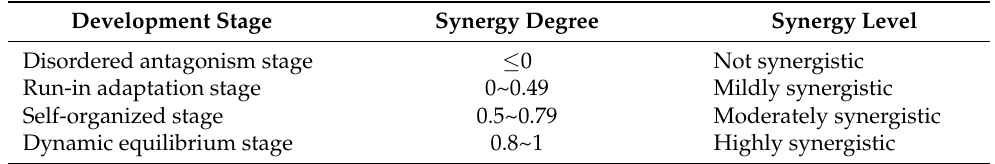
Table 2. Division of system synergistic development stage. Development Stage Synergy Degree Synergy Level Disordered antagonism stage ≤ 0